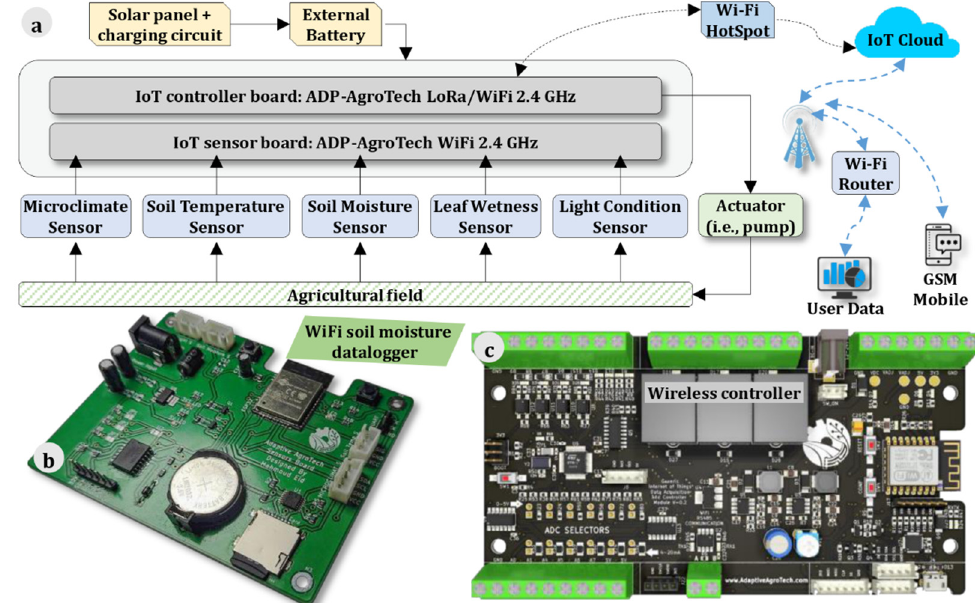
Figure 1. An IoT monitoring and control system for scientific irrigation scheduling developed by Adaptive AgroTech, showing ( a ) the main components of the system, ( b ) WiFi soil moisture datalogger, and ( c ) wireless controller (Source: www.AdaptiveAgroTech.com (accessed on 15 January 2022)).